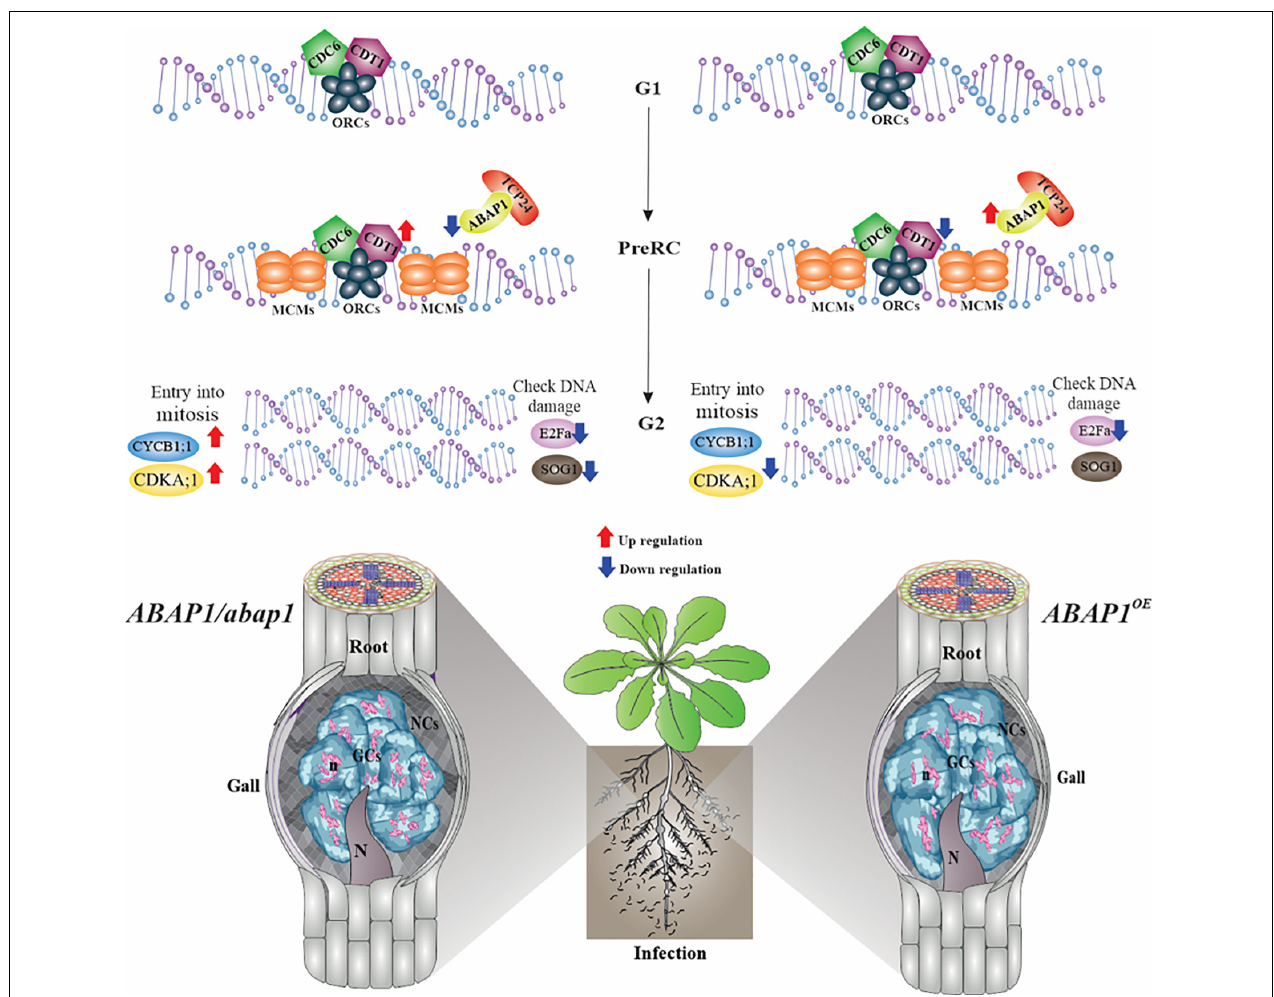
FIGURE 9 | Schematic view and proposed model for ABAP1 control in galls during DNA replication and S-phase progression. ABAP1 expression senses and responds to intra- and extracellular signals like nematode infection, leading to changes in the expression pattern of gene members of the pre-replication complex and other S-phase genes. Genes analyzed by in situ hybridization are illustrated on the upper DNA drawing, and genes analyzed by qRT-PCR are shown with arrows of up- and downregulation upon increased (red arrows) or decreased (blue arrows) ABAP1 expression. When ABAP1 is downregulated (left side), genes like CDT1 , CDKA;1 , and CYCB1;1 increased their expression levels and galls showed more mitotic activity also illustrated in the drawing on the left side. On the other hand, when the ABAP1 is overexpressed (right side), decreased activity of the pre-RC can possibly regulate negativity of other partakers of the cell cycle such as CDT1 and CDK1 decreasing mitotic events and inhibiting DNA replication in galls. These might lead to aberrant forms of the nuclei in giant cells illustrated at the right side. Overall, these changes might drastically affect the nematode development and